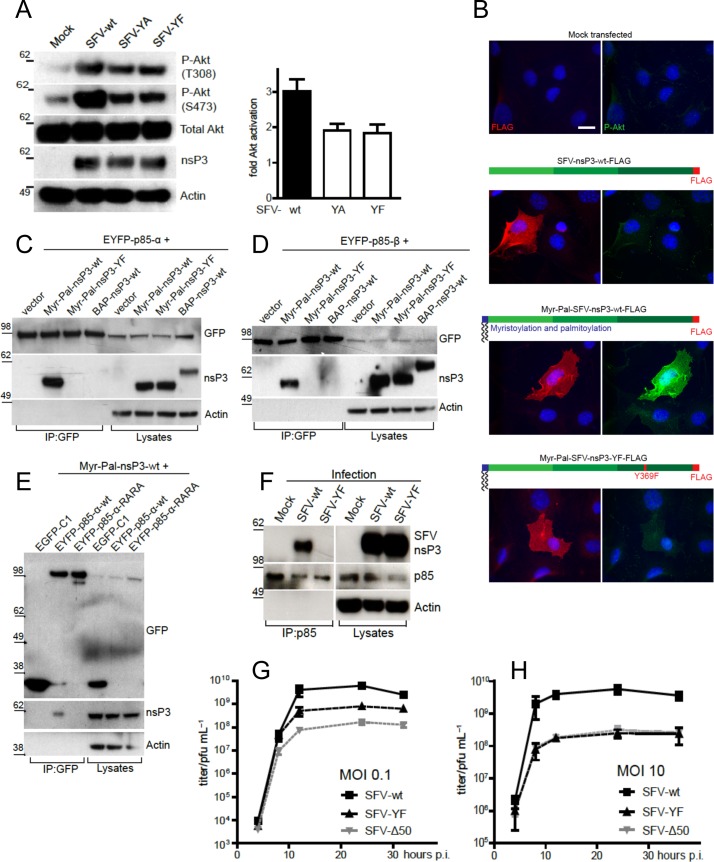
The YXXM motif in SFV nsP3 mediates PI3K/AKT hyperactivation.A. AKT activation in BHK cells infected at MOI 10 as indicated and lysed at 8 hpi, together with densitometry of phosphorylated AKT (S473), normalised to total AKT signals and relative to mock-infected cells (mean of three independent experiments ± SEM). B. Immunofluorescence showing activation of AKT (S473, green) in MEFs transfected for 24 h with the indicated DNA plasmids (red: FLAG-nsP3, blue: nuclei). Representative epifluorescence images are shown. Scale bar: 20 μm. Co-immunoprecipitations showing the interaction between EYFP-p85−α (C and E) or EYFP-p85−β (D) in HEK293T cells transfected with the indicated constructs for 24 h. EYFP-tagged p85 constructs were immunoprecipitated with an anti-GFP antibody. BAP: biotin acceptor peptide, Myr-Pal: myristoylation and palmitoylation. F. Interaction of endogenous p85 and viral nsP3 in lysates of BHK cells infected at MOI 10 for 8 h, after immunoprecipitation with an anti-p85 antibody. Growth curves of SFV-wt and SFV-YF in BHK cells infected at MOI 0.1 (G) or 10 (H) for the indicated times. Virus titres at each time point were determined by plaque assay. Data show the mean ± SEM of three experiments.